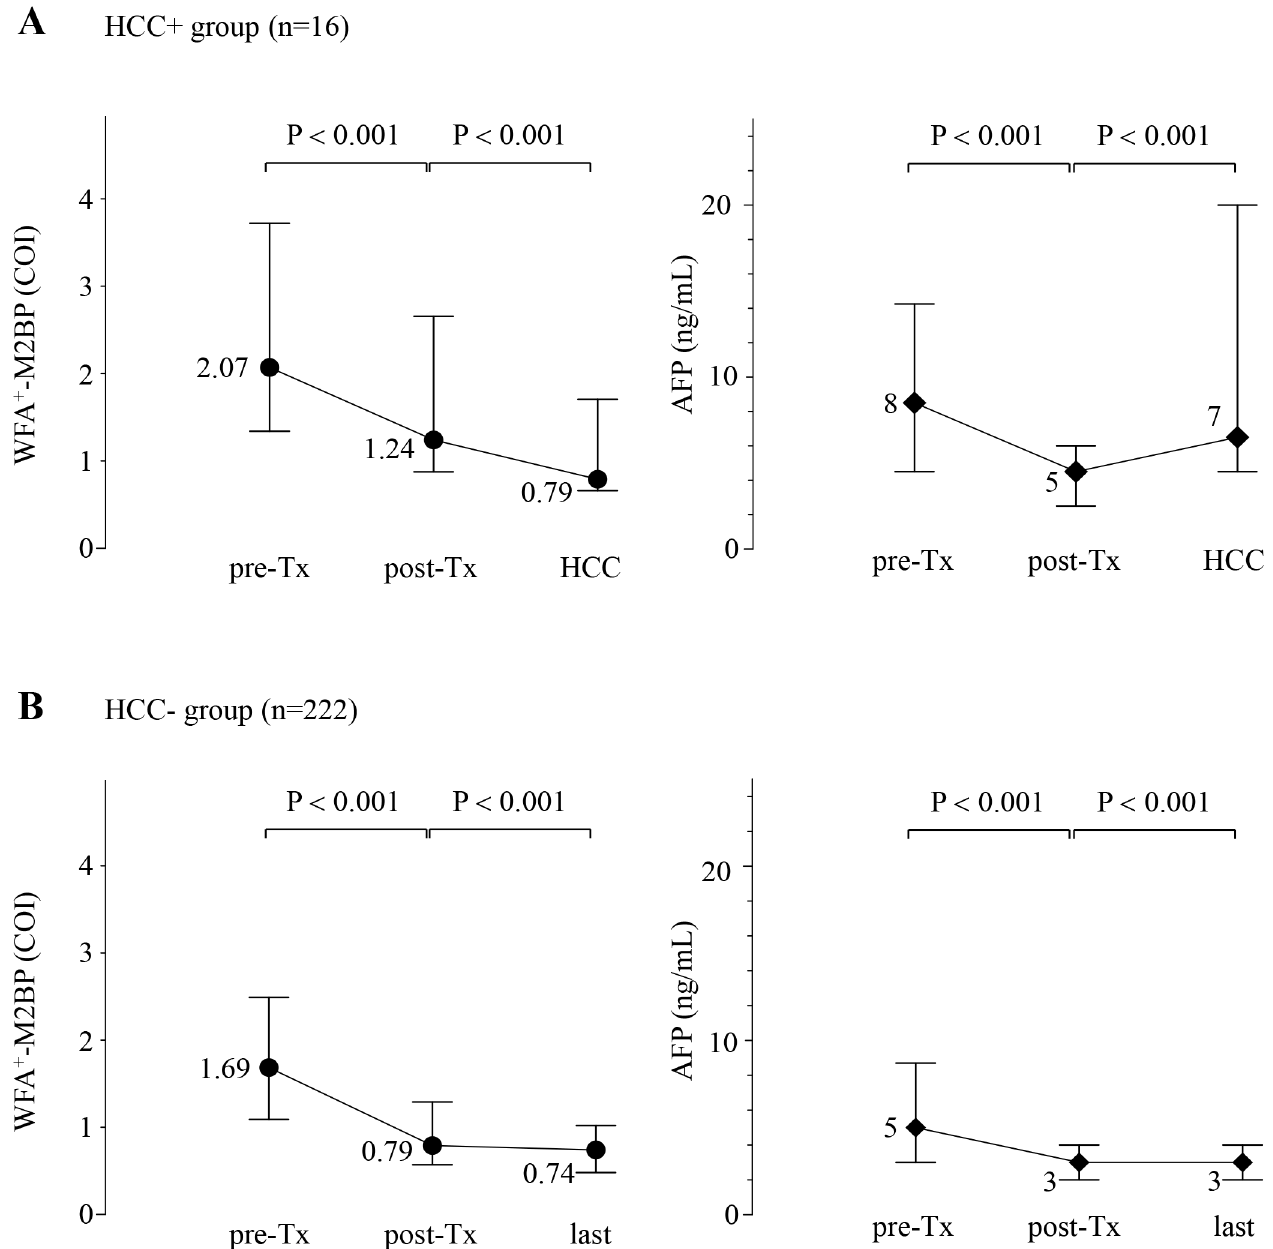
Fig 4. Chronological changes in the WFA + -M2BP and AFP values at pre-treatment, post-treatment, the time of HCC development, and the last visit of the 238 patients with sustained virological response. Dots represent the median serum WFA + -M2BP values at each time point, and the error bar represents the interquartile range. Diamonds represent the median serum AFP values at each time point, and the error bar represents the interquartile range. (A): Patients who developed HCC (n = 16). WFA + -M2BP values were decreased at post-treatment and increased at HCC development. And AFP values were decreased at post-treatment and increased at HCC development. (B): Patients who did not developed HCC (n = 222). WFA + -M2BP values were decreased at post-treatment and last clinical visit. And AFP values were decreased at post-treatment and last clinical visit.